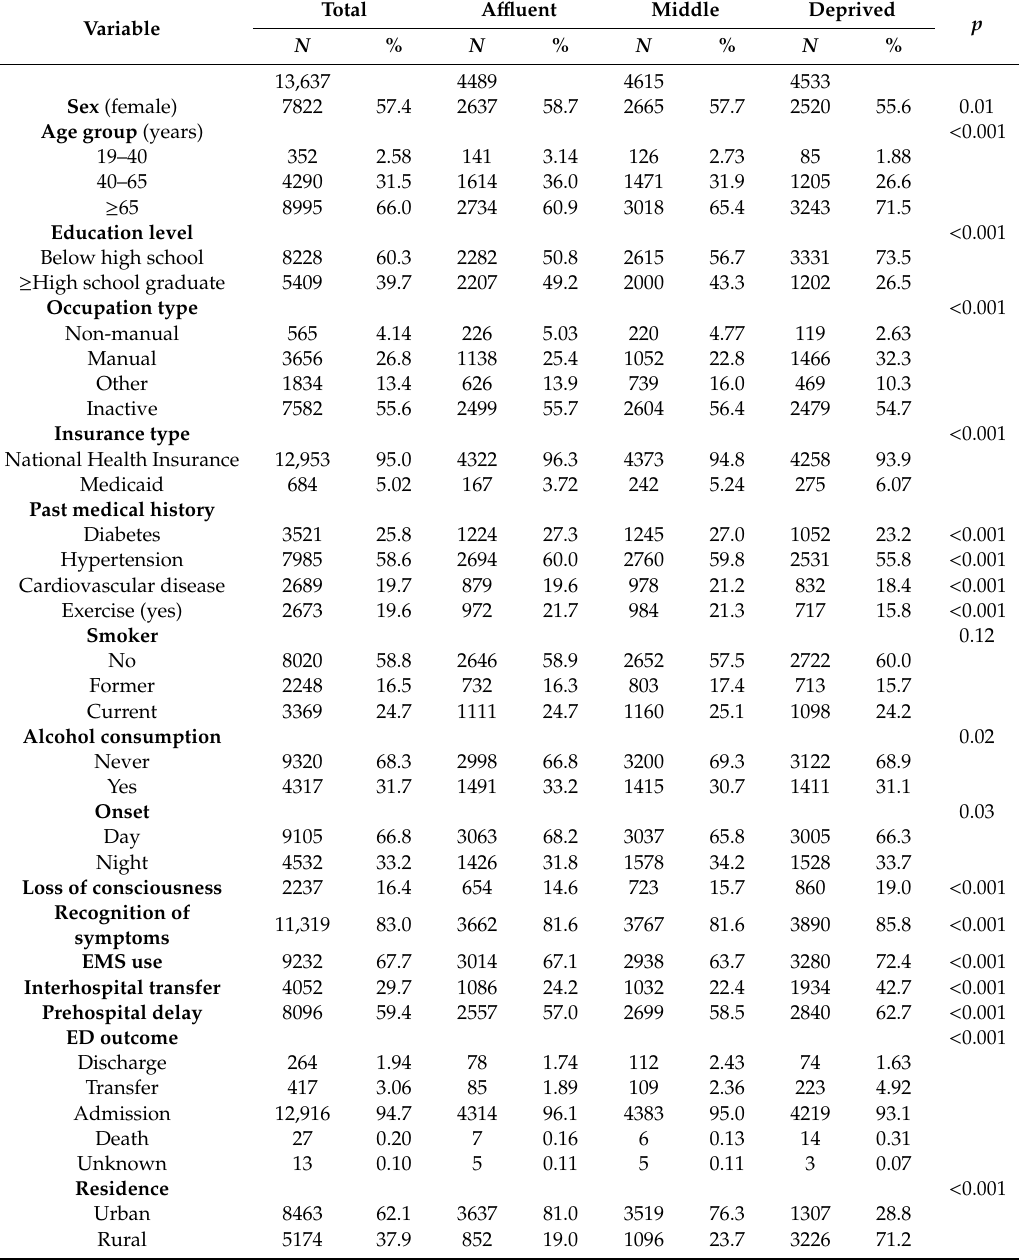
Table 1. Characteristics of patients by area-level socioeconomic status